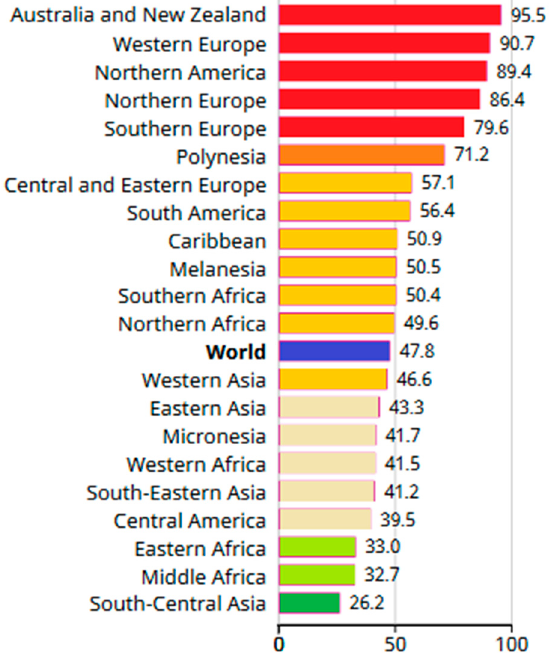
Figure 2. Breast cancer age standardized rate (ASR per 100,000) in 2020 for women [1].